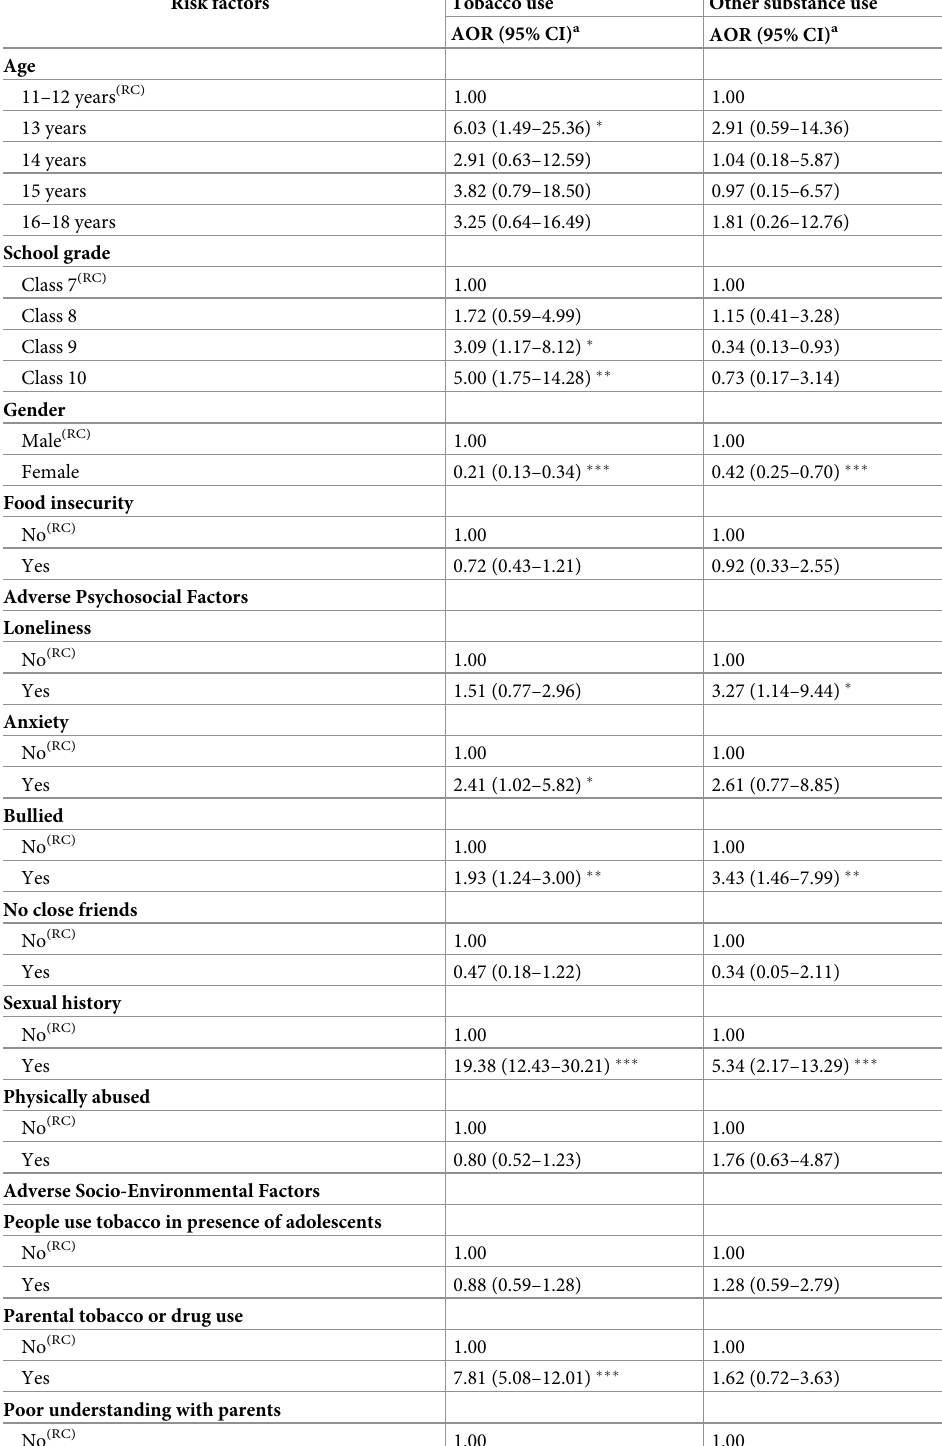
Table 3. Results of the logistic regression analyses of the relationship between socio-demographics and adoles- cent’s adverse experiences, and tobacco and other substance use in Bangladesh: Global School-Based Health Sur- vey (GSHS),